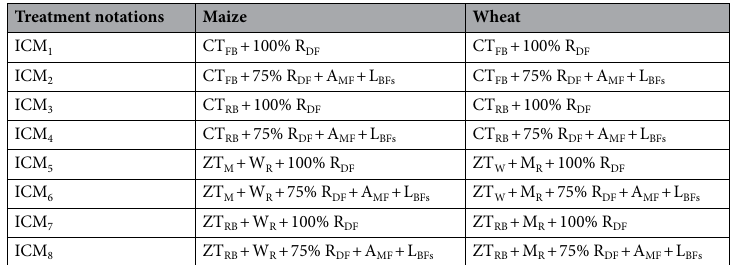
Table 4. Description of integrated crop management (ICM) modules adopted in maize and wheat crops during the five years ˈ fixed plot experimentation. # ICM 1&2 = conventional flatbed maize & wheat (CT FB ); ICM 3&4 = conventional raised bed maize & wheat (CT RB ); ICM 5&6 = zero-till (ZT) flatbed maize with wheat residue at ~ 3 Mg ha −1 (ZT M + W R ) & ZT wheat with maize residue at ~ 5 Mg ha −1 (ZT W + M R ), and ICM 7&8 = ZT raised bed maize with wheat residue (ZT RB + W R ) & ZT wheat with maize residue (ZT RB + M R ). # R DF = recommended fertilizers for maize / wheat 150:26.2:50 / 120:26:33 NPK kg ha bio-fertilizer; A MF = arbuscular mycorrhizal fungi. # Integrated weed management (maize): ICM 1-4 = atrazine- pre-emergence (P E ) fb 1hand weeding (H W ) mulch; ICM 5-8 = glyphosate-preplant (P P ) + atrazine-P E fb I H W mulch.